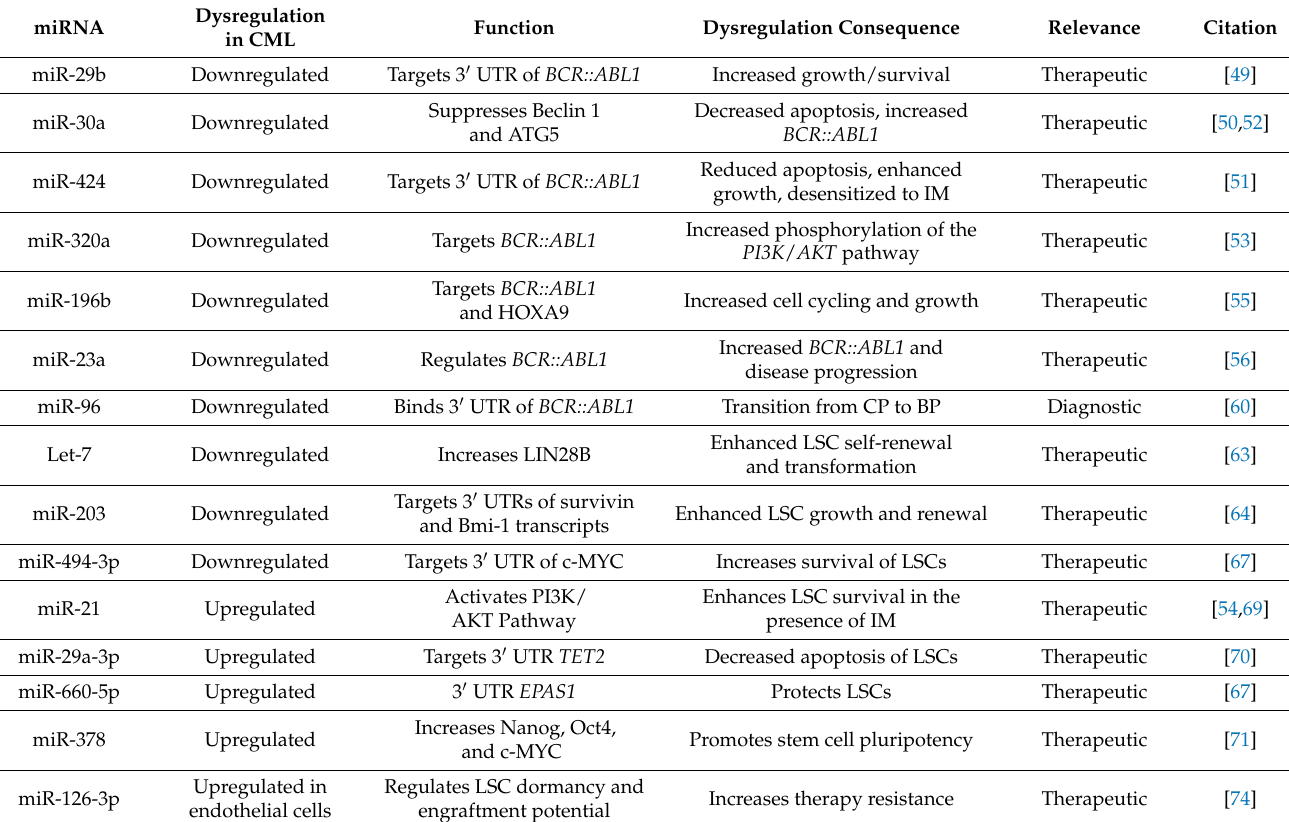
Table 1. Summary of discussed miRNAs dysregulated in